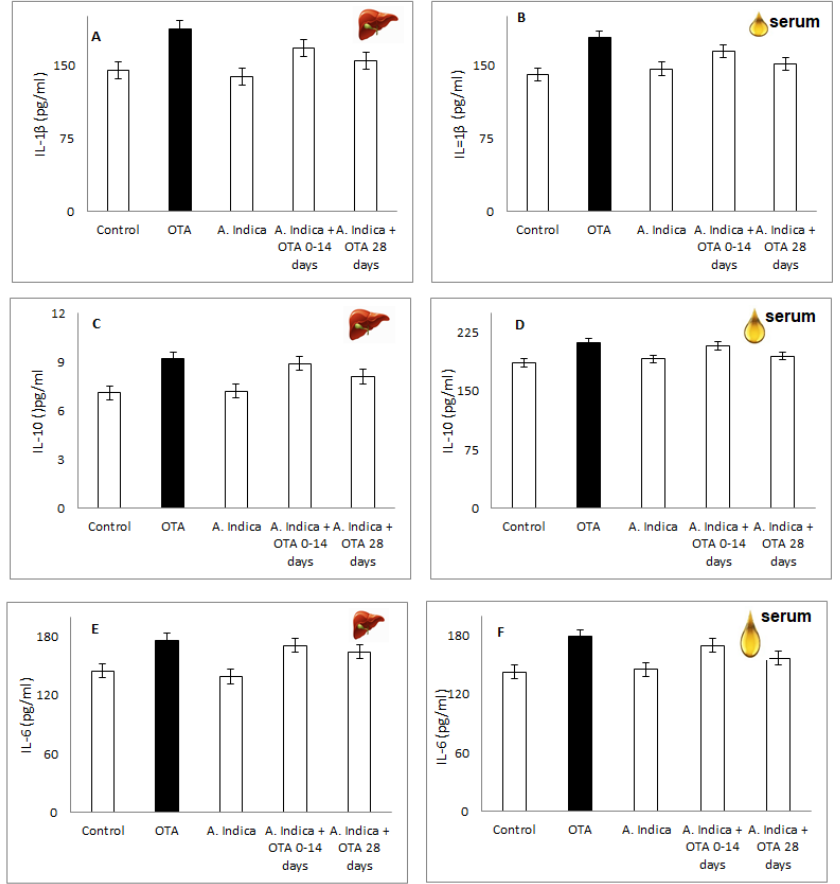
Figure 8. The A. indica effects on OTA-induced mycotoxicity and the expressions of IL-1b ( A , B ), IL-6 ( C , D ), IL-10 ( E , F ) in mouse liver homogenate/serum samples; mean ± S.E. p <